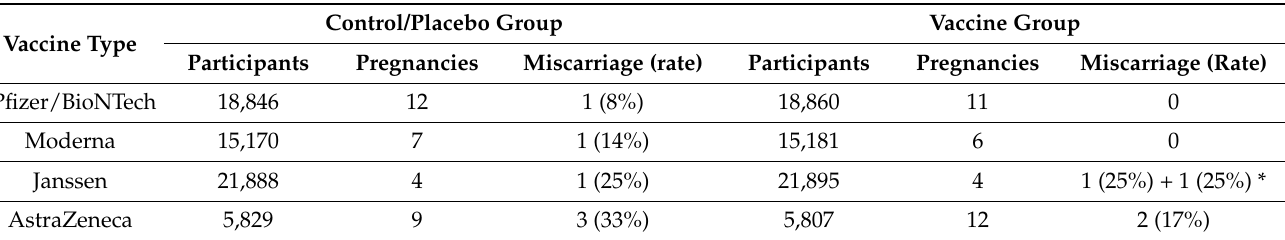
Table 2. Accidental pregnancies reported in COVID-19 vaccine